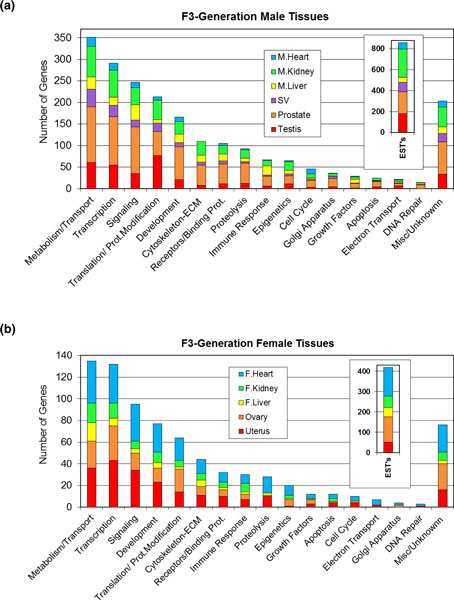
Number of genes differentially expressed in F3 generation vinclozolin lineage tissues and
their distribution among main functional categories. (a) Male (M) heart, kidney, liver,
testis, seminal vesicle (SV), and prostate. (b) Female (F) heart, kidney, liver, uterus, and
ovary. ECM, extracellular matrix.